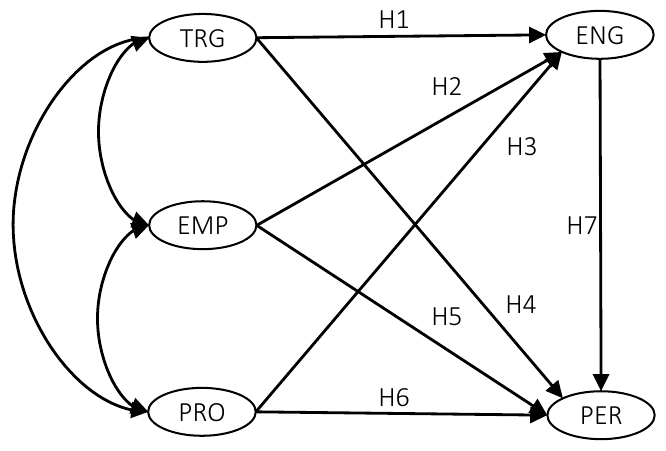
Figure 1. Research conceptual